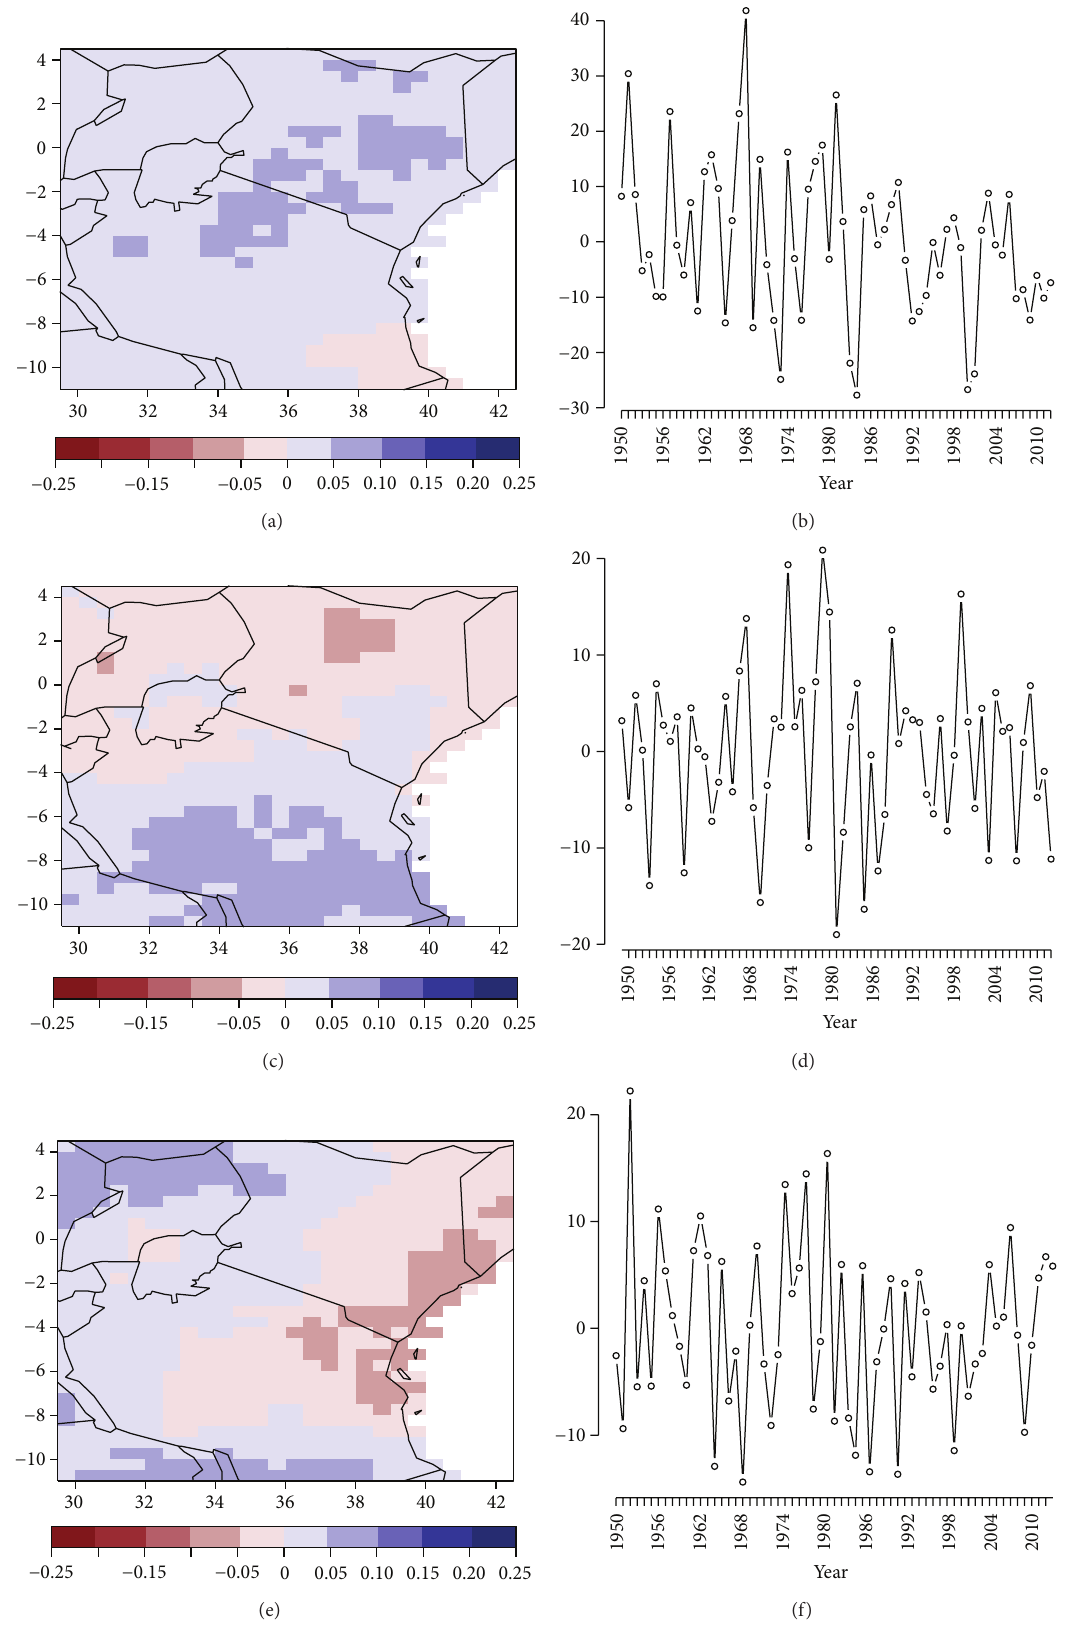
Figure 8: Same as Figure 3, but for long rains (MAM)